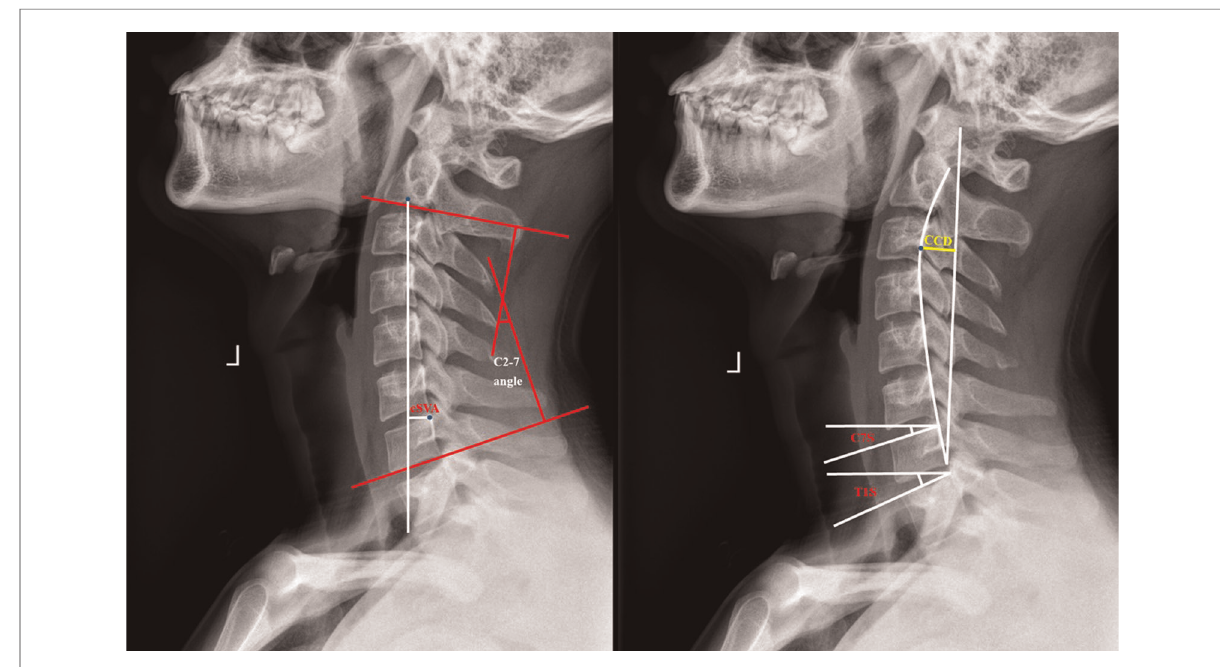
FIGURE 5 Lateral radiograph for measuring radiographic parameters. cSVA, C2-7 sagittal vertical axis; CCD, cervical curve depth; C7S, C7 Slope; T1S, T1 Slope.